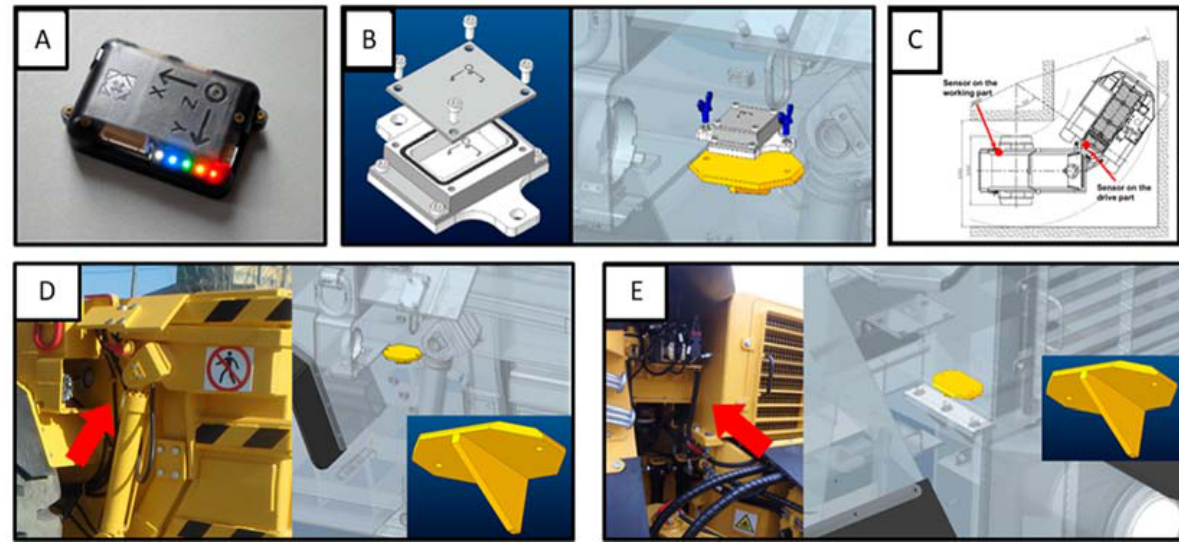
Figure 3. Data acquisition layer—main components: ( A ) NGIMU sensor unit; ( B ) Steel housing of the device and the method of installation on the machine; ( C ) Positions of the sensor marked with red dots; ( D ) Exact location (red arrow) of the sensor on the back of the machine; ( E ) Exact location (red arrow) of the sensor on the front of the machine.